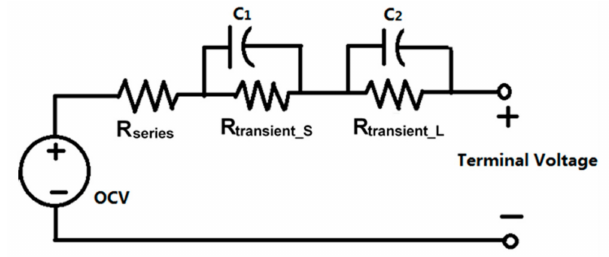
Figure 1. Thevenin with runtime-based